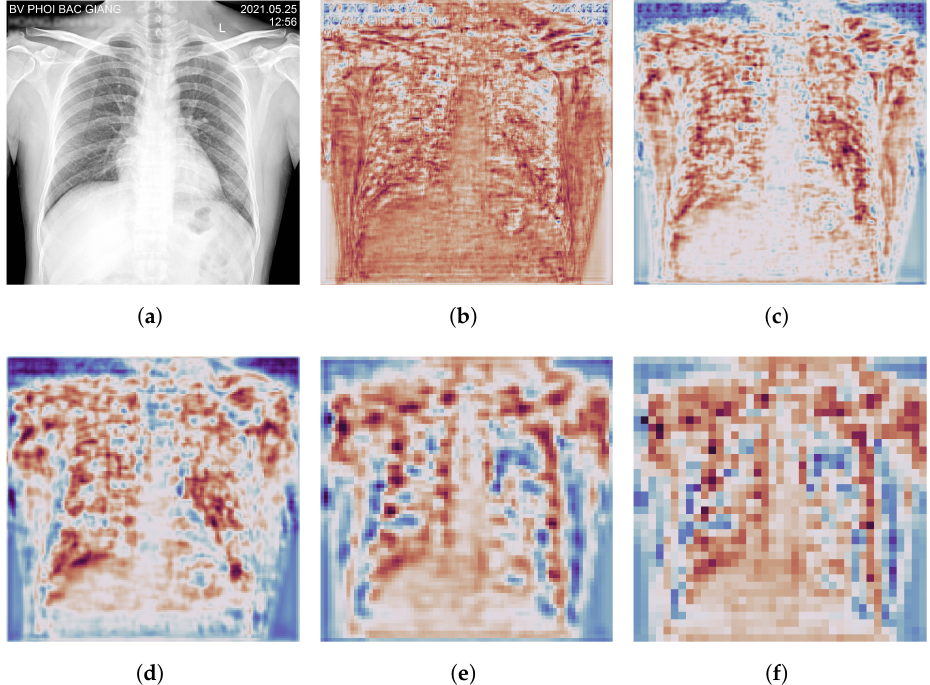
Figure 7. CXR and different-scale feature maps extracted by the FPN. ( a ) Input CXR. ( b ) P2. ( c ) P3. ( d ) P4. ( e ) P5. ( f ) P6.